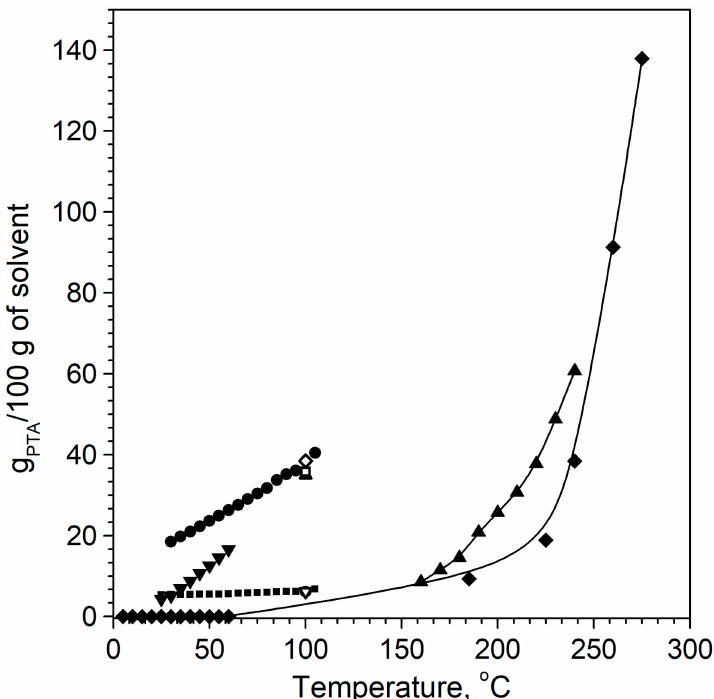
Figure 1. Solubility of PTA in ionic liquids and conventional solvents; figure adapted from